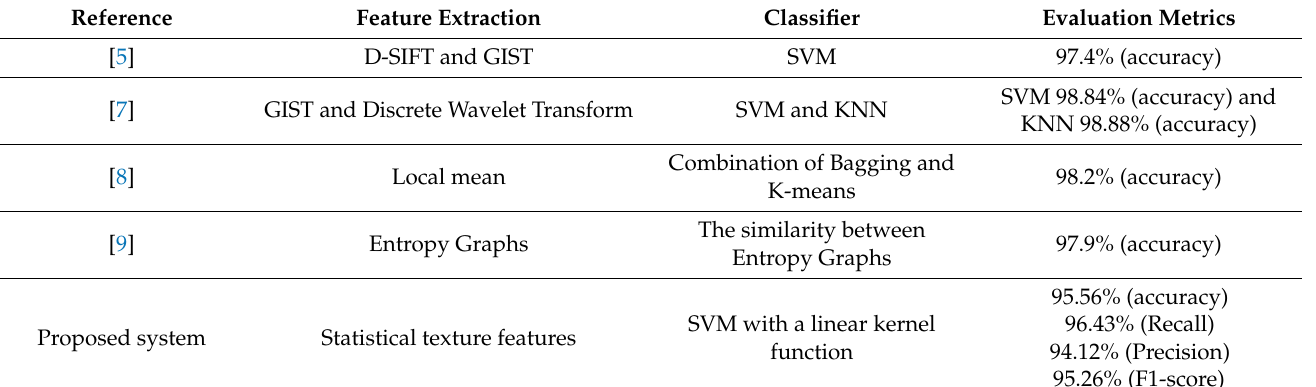
Table 9. Comparison with ML-based methods in terms of evaluation metrics